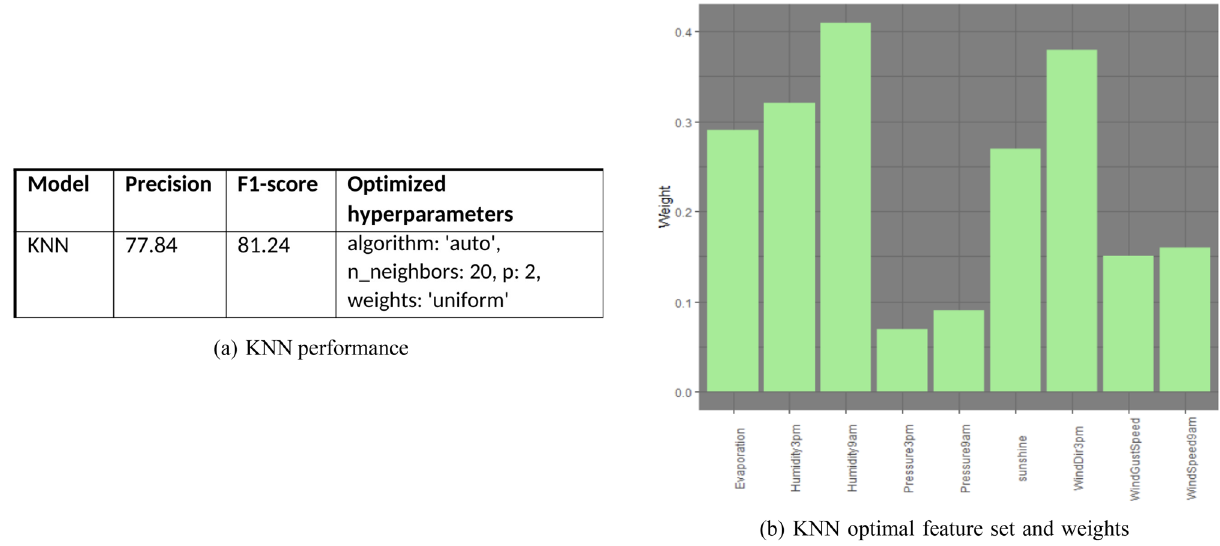
Figure 13. KNN performance and feature set.